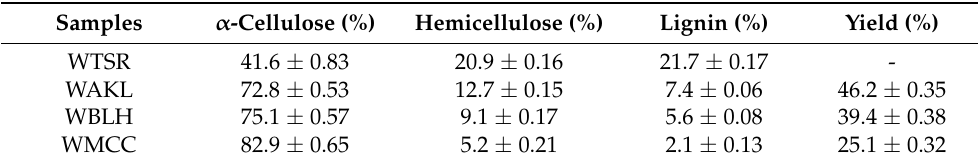
Figure 1. Micrographs of ( a ) WAKL, ( b ) WBLH, and ( c ) WMCC with magnifications of × 100 (i) and × 3000 (ii) under SEM viewing. Table 1. Chemical composition and production yield of fibre